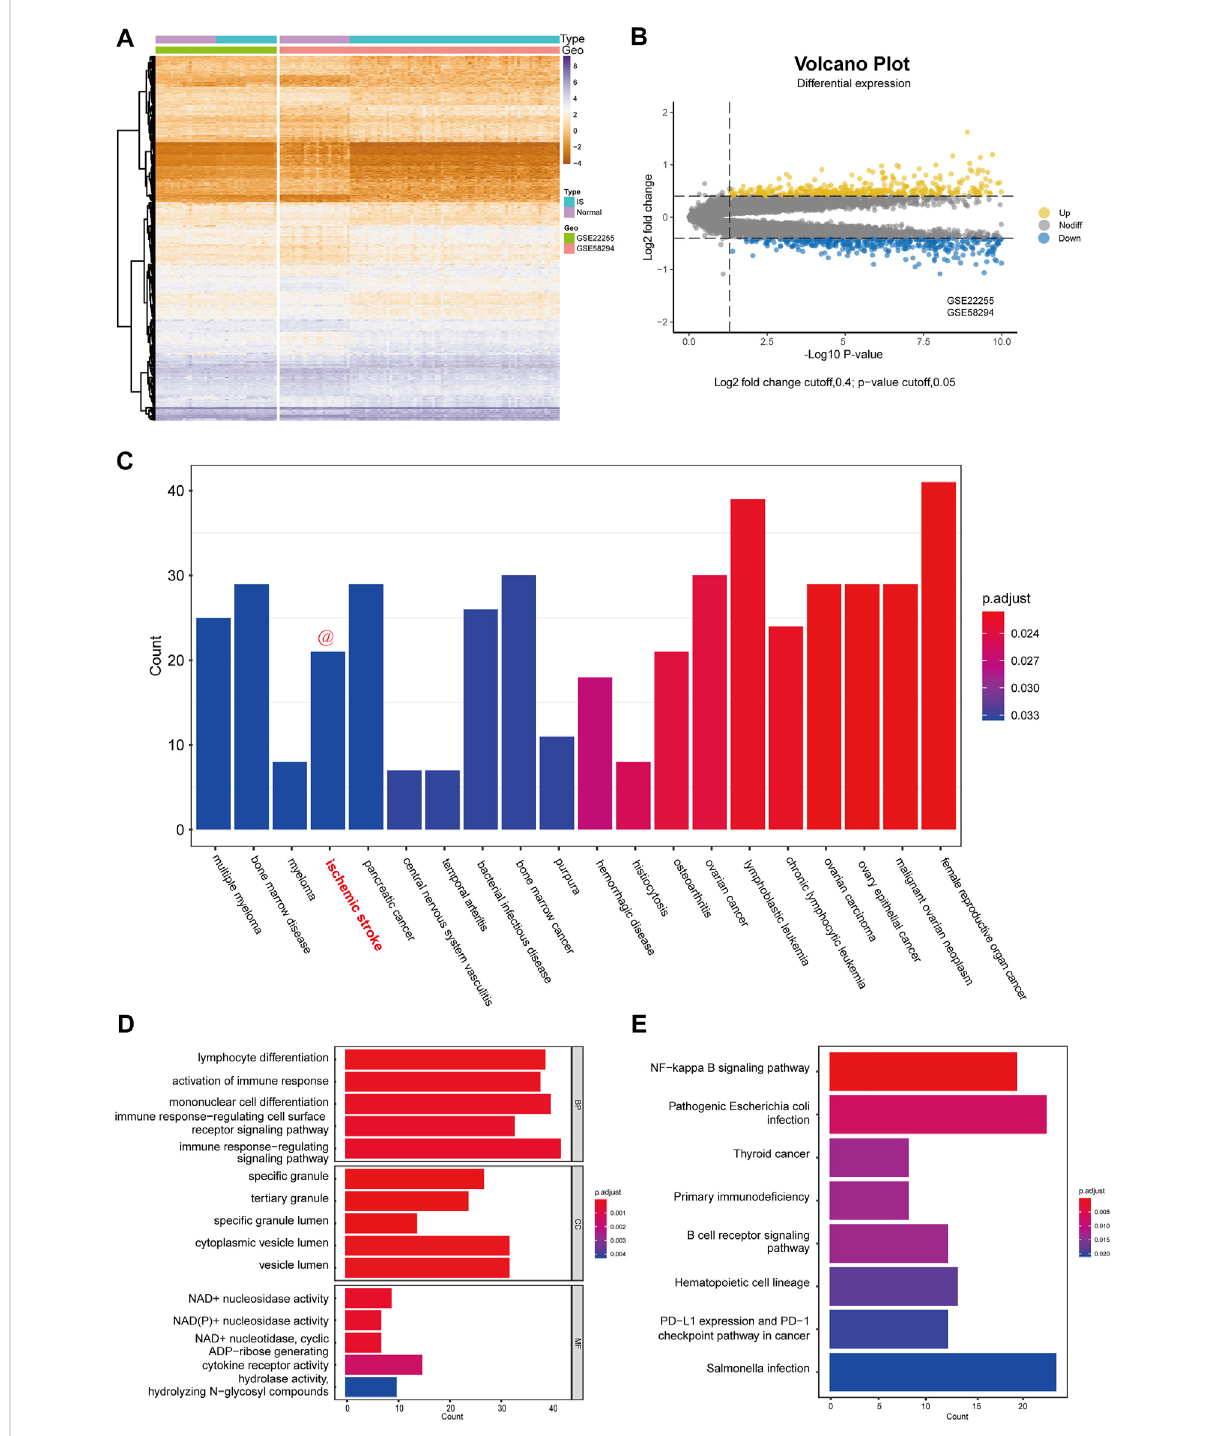
FIGURE 2 Differential expression analysis and functional enrichment analysis. (A) Cluster heatmap for DEmRNAs in GSE58294 and GSE22255 dataset. Yellow represents high gene expression and purple represents low expression. (B) Volcano plot for DEmRNAs in GSE58294 and GSE22255 dataset. (C) Disease enrichment analysis of DEGs. (D) GO functional enrichment analysis of DEGs. (E) KEGG pathway analysis of